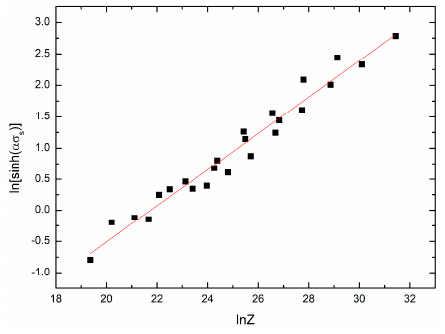
Figure 9. The relationship between ln[sinh( )] s